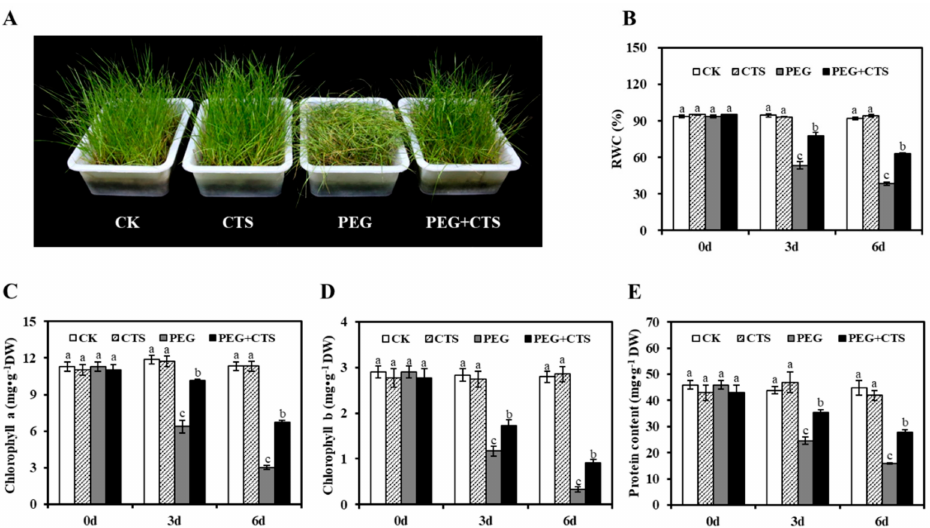
Figure 1. Chitoscan (CTS) pretreatment improved annual ryegrass resistance to osmotic stress tolerance. ( A ) Phenotype of annual ryegrass after polyethylene glycol (PEG) treatment with or without CTS. E ff ect of CTS on changes of annual ryegrass relative water content ( B ), chlorophyll content ( C , D ), and protein content ( E ) before and after osmotic stress treatment. Vertical bars represent mean values ± SD for each mean. Di ff erent letter indicates significant di ff erences at given day ( P ≤